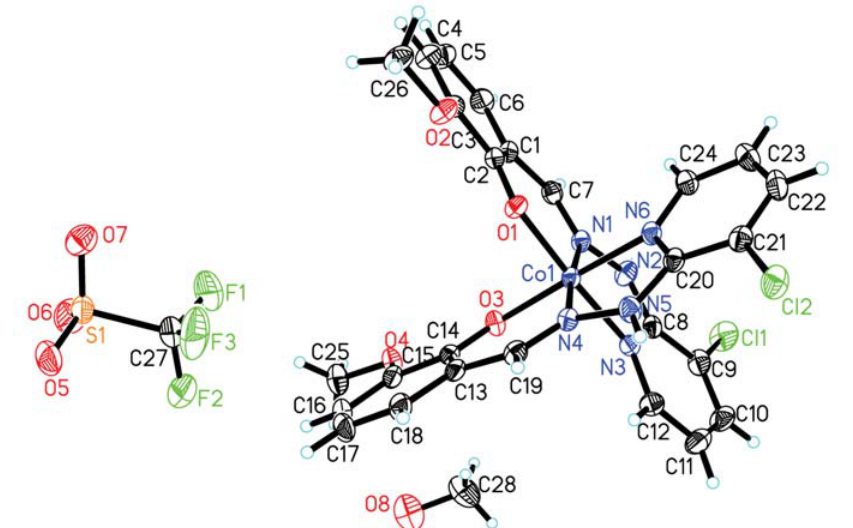
Figure 5. Crystal structure of 2 . Displacement is drawn at the 30% probability level.